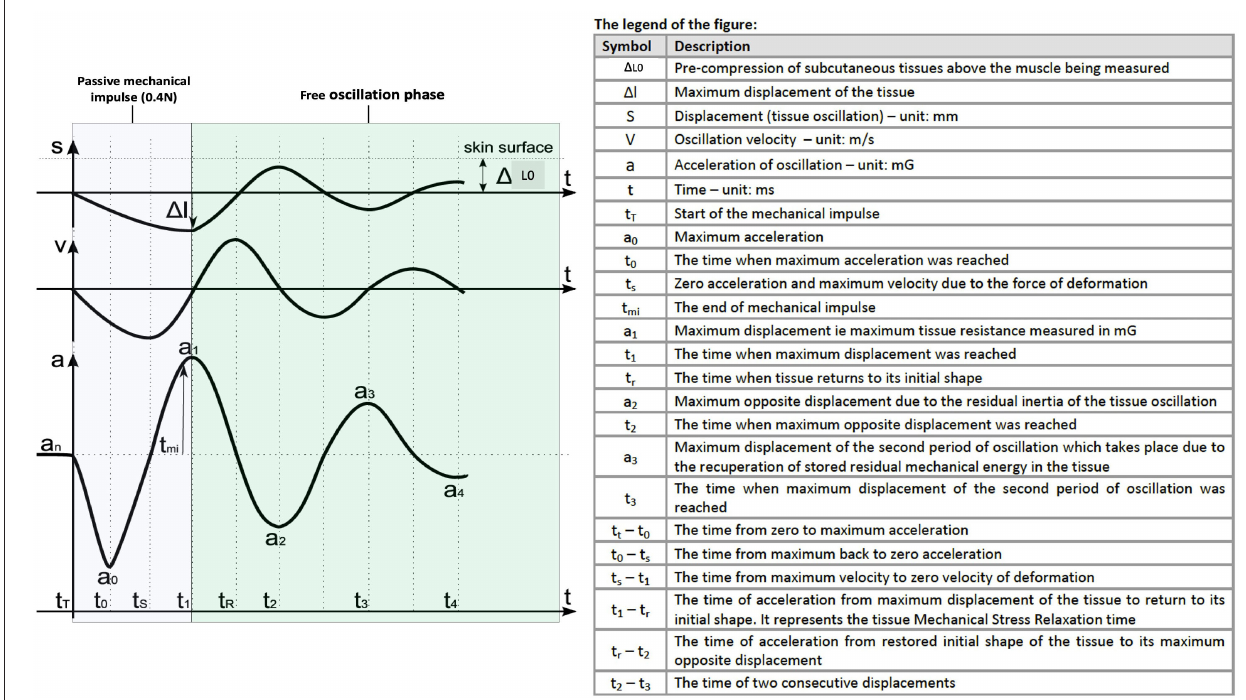
Frontiers in Sports and Active Living |